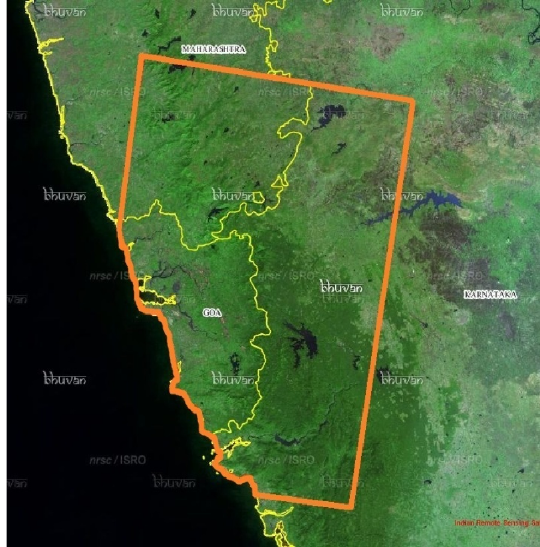
Figure 1. Study area pertaining to part of Western Ghats, India (sourced from